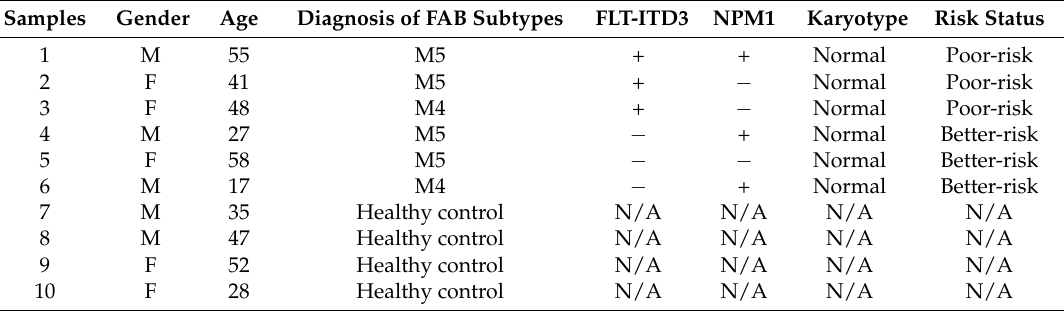
Table 1. Clinical information of human samples used in